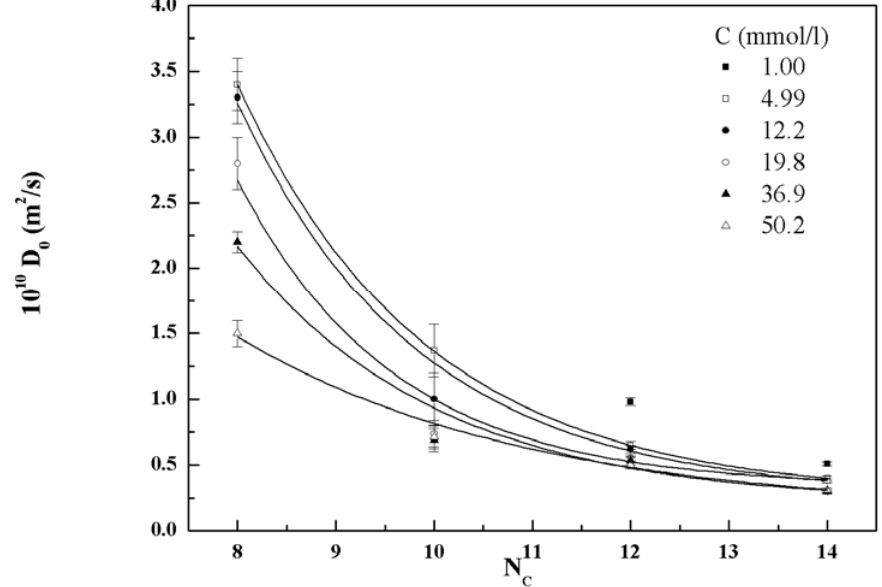
Figure 5. Diffusion coefficient (D chains of the gemini surfactants 4a–d at various concentrations. Lines are an eye-guide only.